Question: What style of plot is this figure drawn as?
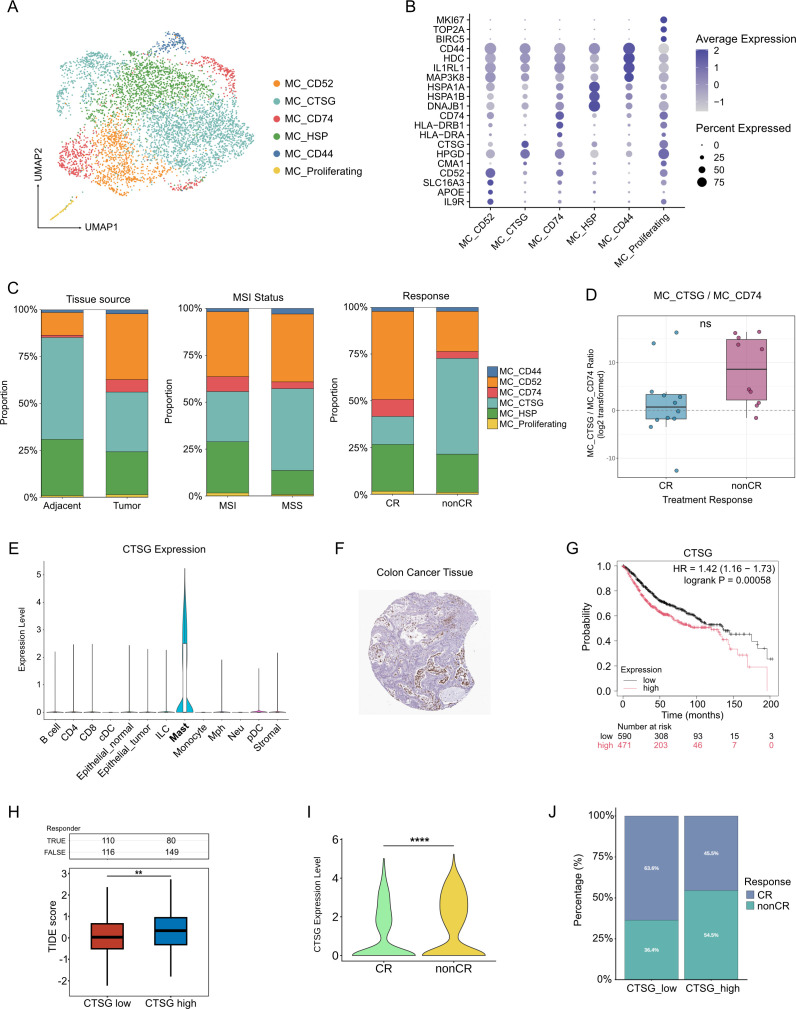
Answer: survival